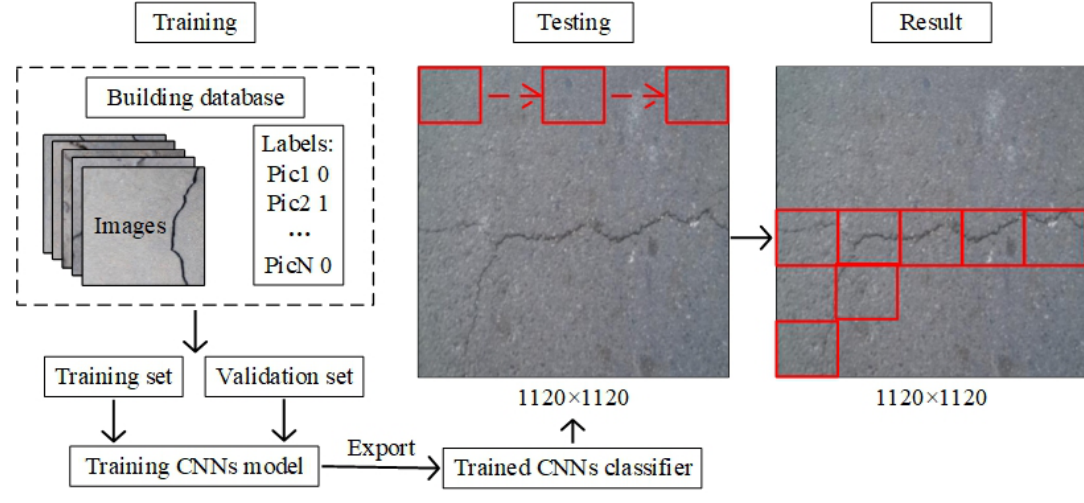
Figure 1. Flowchart of crack detection.